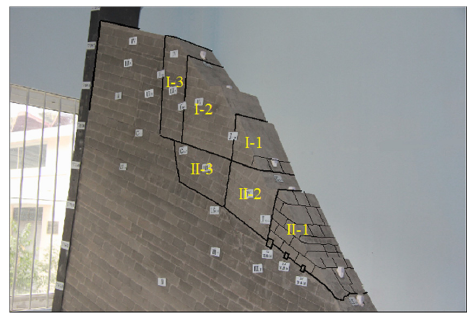
Figure 12. Failure sequence diagram of the slip blocks.